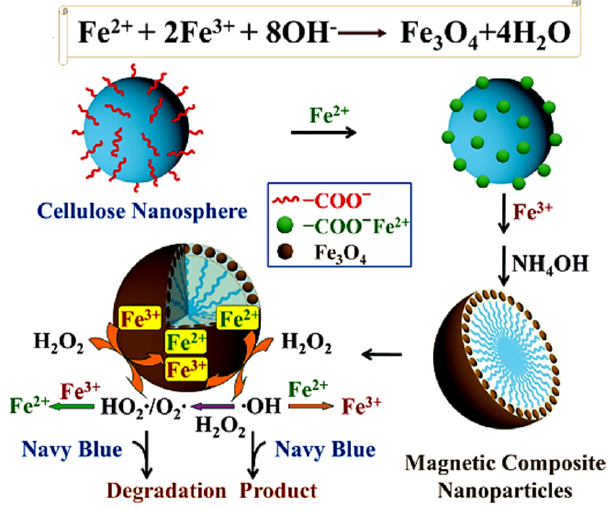
Figure 6. The formation and catalytic mechanism of MNPs. Magnetic iron oxides were anchored on the cellulose nanospheres by using a co-precipitation process; the rapid removal of textile dye Navy blue was achieved in the Fenton-like system. Reprinted from [163]. Copyright 2015, with permission from Elsevier Ltd.